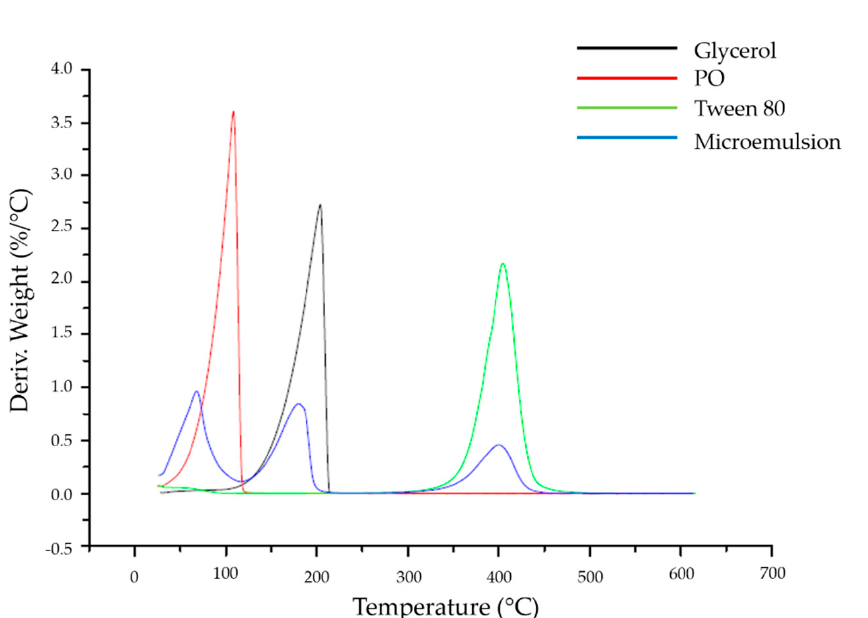
Figure 14. DTG of the individual components and the